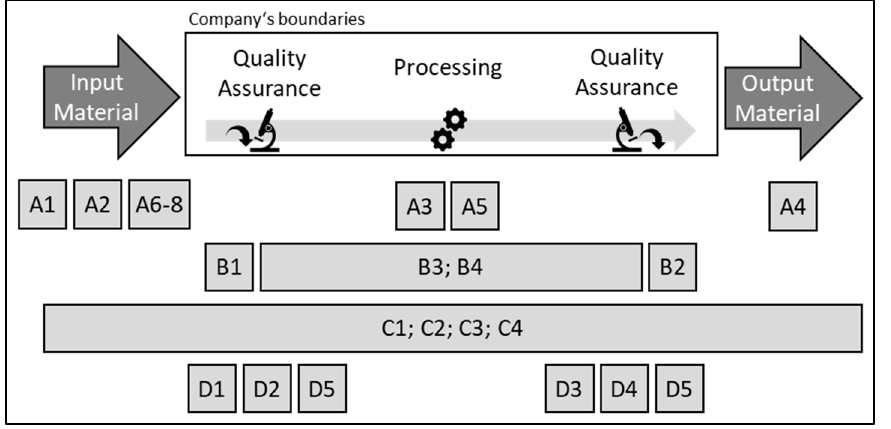
Figure 2. Allocation of the questions along the process chain.